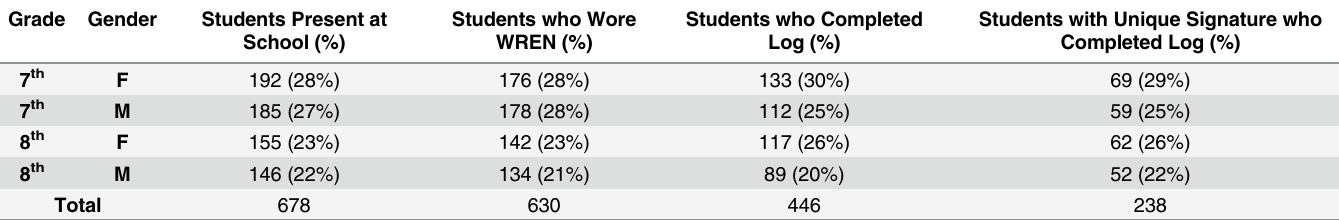
Table 2. Grade and gender of school population and participants: number of students and percent of total.